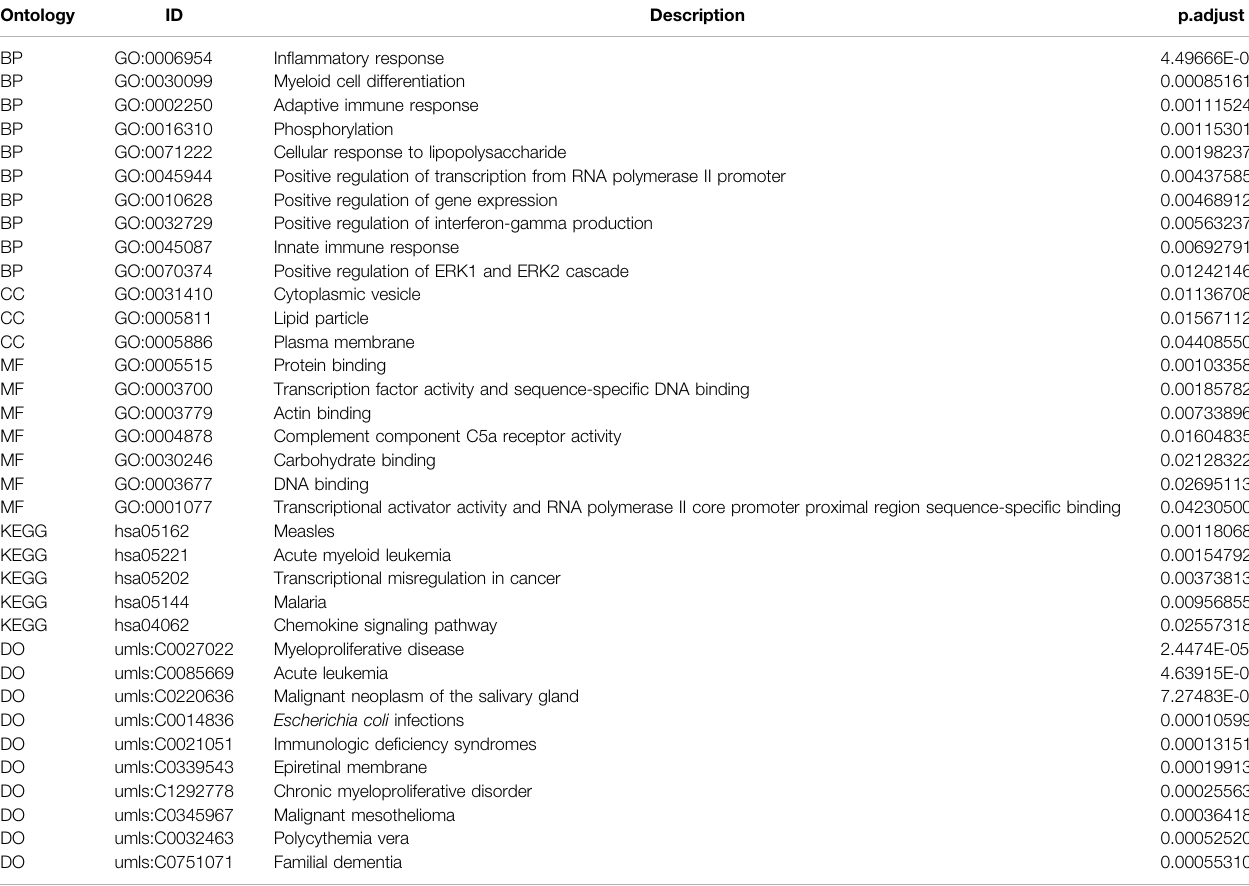
TABLE 4 | Functional annotation of hub genes.